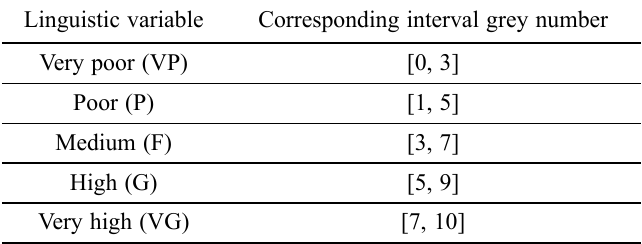
Table 2. Linguistic scales for the ratings of alternatives Linguistic